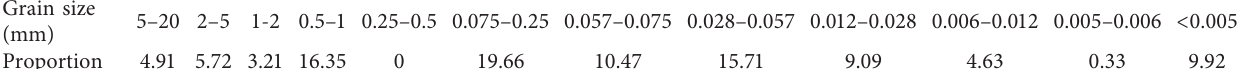
Table 3: Dial indicator of different particle size distribution of samples (%).